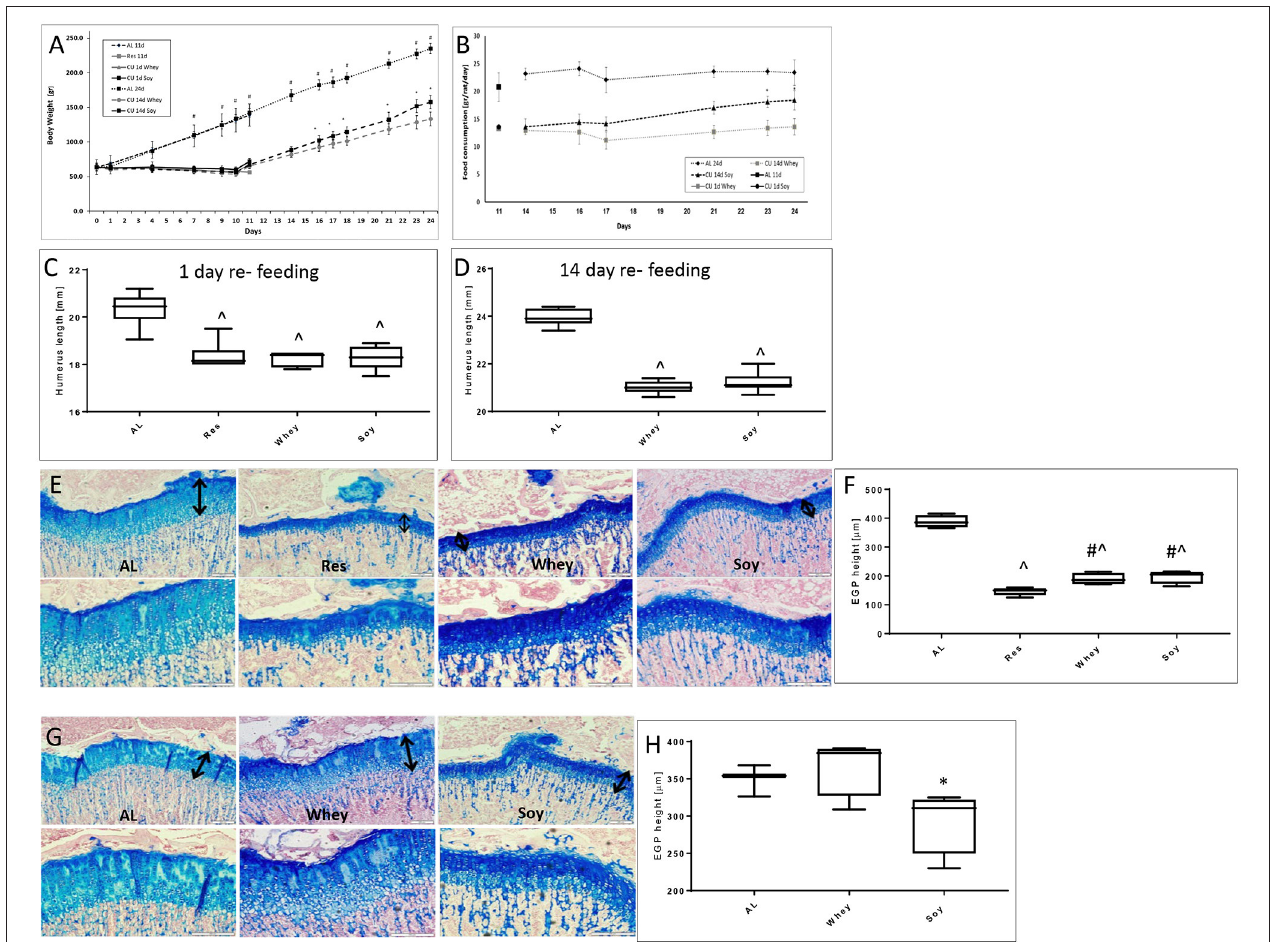
FIGURE 3 | Catch-up growth experiment. (A) Animal body weight, (B) food consumption, (C) humerus length 1 day refeeding, (D) humerus length 14 days refeeding, and (E) representative stained sections of the EGP at 1 day refeeding (upper panel magnification × 10; lower panel magnification X 20); (F) EGP height at 1 day of refeeding. (G) Representative stained sections of the epiphyseal growth plate (EGP) at 14 days refeeding (upper panel magnification × 10; lower panel magnification X 20). The black arrows indicate the height of the growth plates. (H) EGP height at 14 days refeeding. Statistical analysis was done by Student’s T -test. The asterisk (*) within the graphs designates significant differences at p < 0.05 for soy vs. whey. The pound sign (#) within the graphs designates significant differences at p < 0.05 for Res vs. Whey/Soy; The caret sign ( ∧ ) within the graphs designates significant differences at p < 0.05 for AL vs. Res/Whey/Soy. (C,D,F,H) The box plots show the minimum, first quartile, median, third quartile, and maximum of humerus length after 1 (C) or 14 days refeeding (D) and EGP height at 1 (F) or 14 days of refeeding (H) . EGP, epiphyseal growth plate; AL, ad libitum ; RES, food restriction; CU, re-fed group, showing catch up